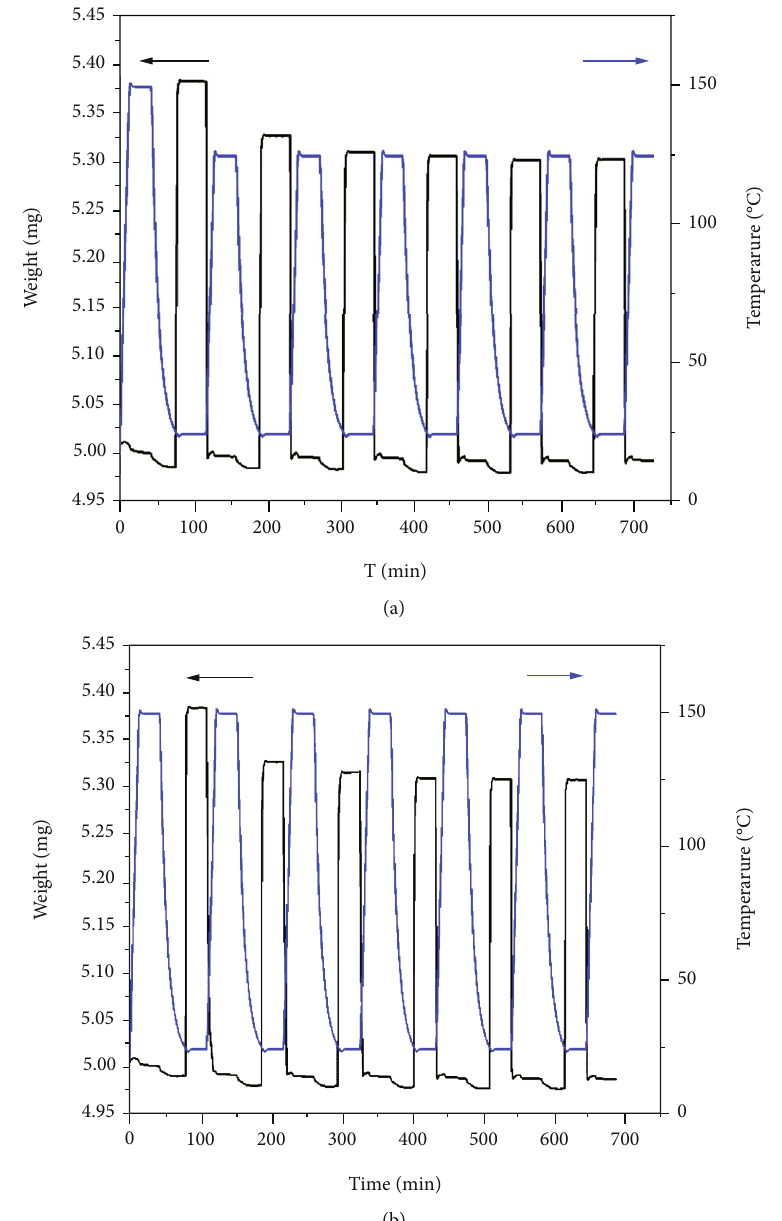
Figure 11: Six gravimetric CO adsorption-desorption cycles on the MA-ZIF-8 at 298K and desorption at 125 ° C and 150 ° C, respectively: (a) 2 125 ° C; (b) 150 °